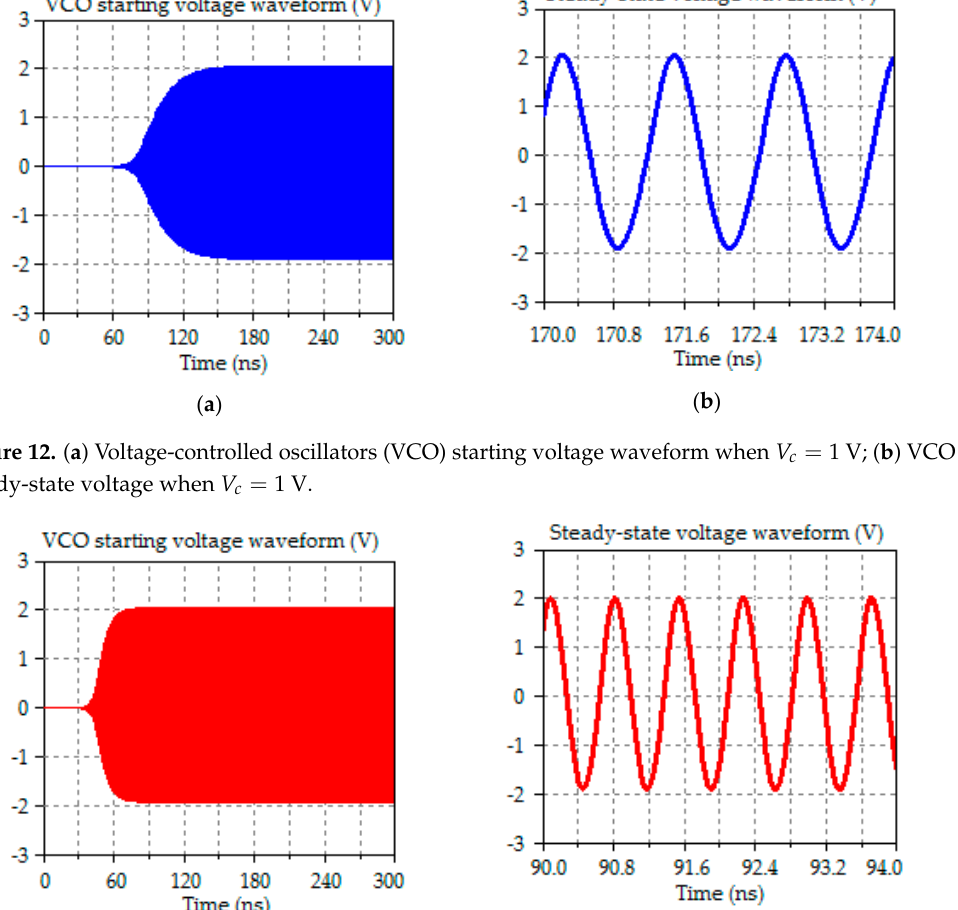
Figure 14. VCO tuning characteristic.